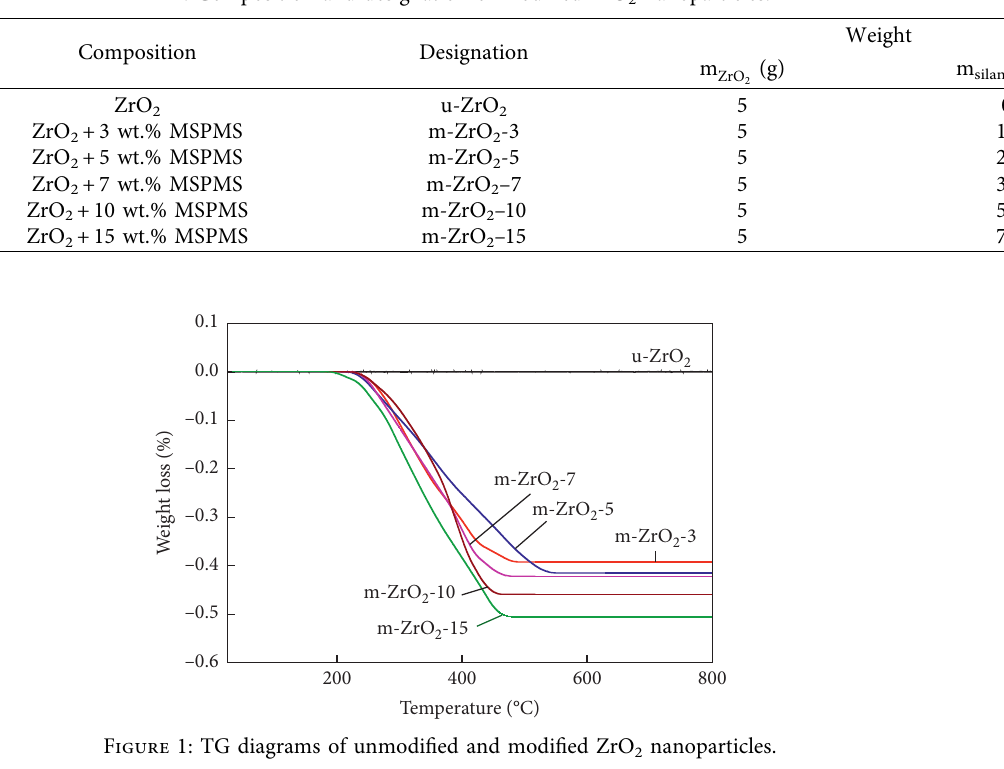
Table 1: Composition and designation of modified ZrO